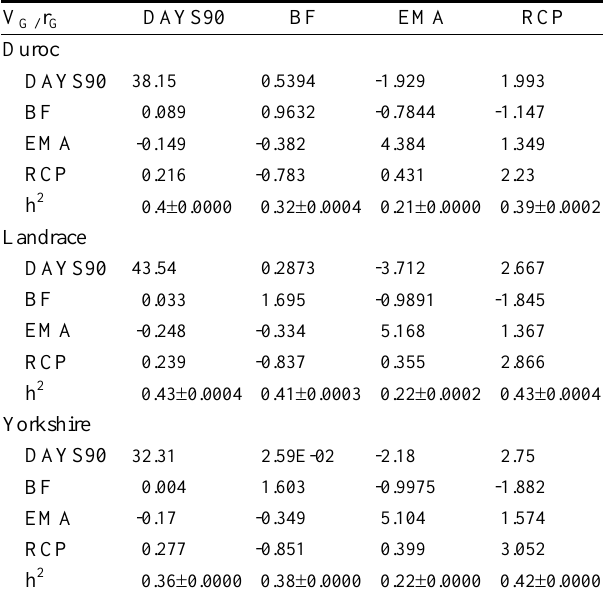
Table 3. Genetic variances (diagonals), covariances (above diagonals), heritability estimates (h 2  SE) and genetic correlation coefficients (below